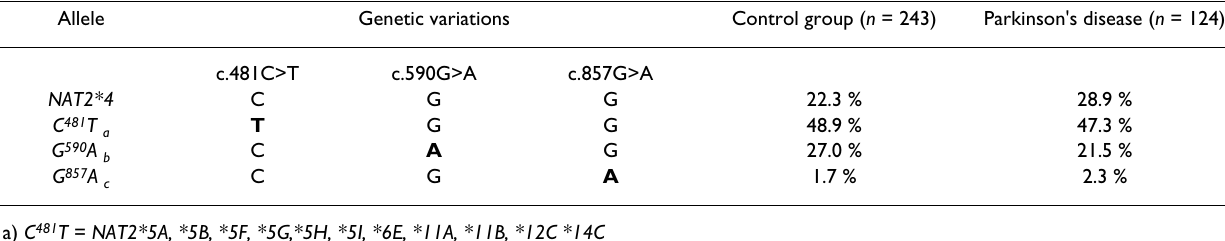
Table 1: Comparison of NAT2 allele frequencies in controls and Parkinson's diseased patients Allele Genetic